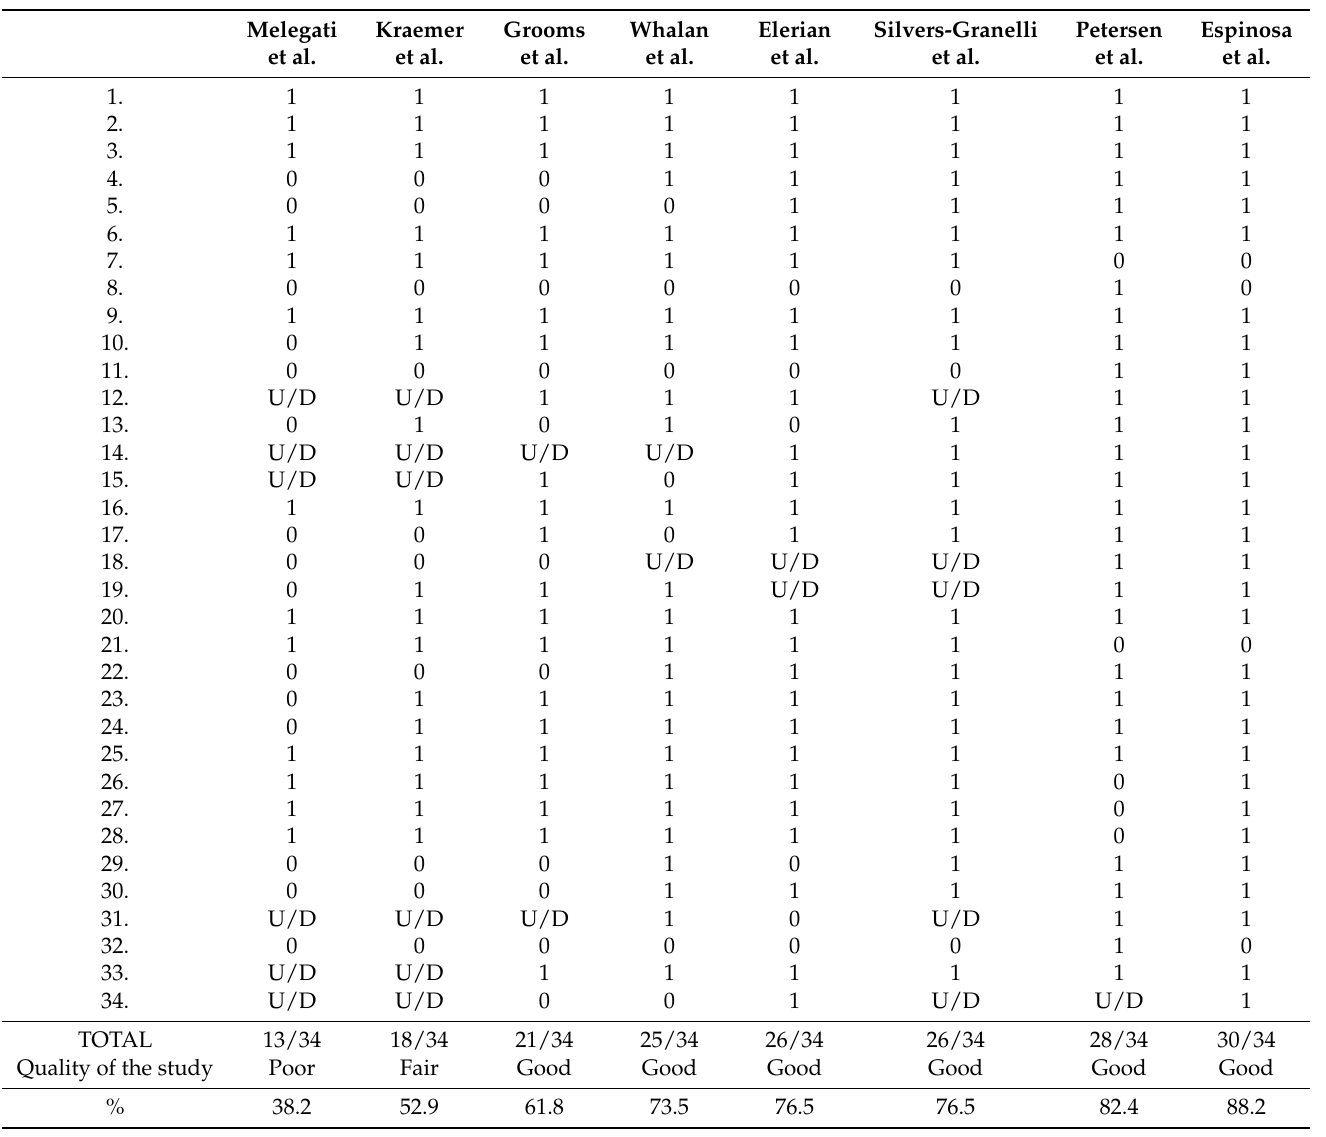
Table 2. Quality assessment: scores of the studies included in the review, using the Kennelly Scale